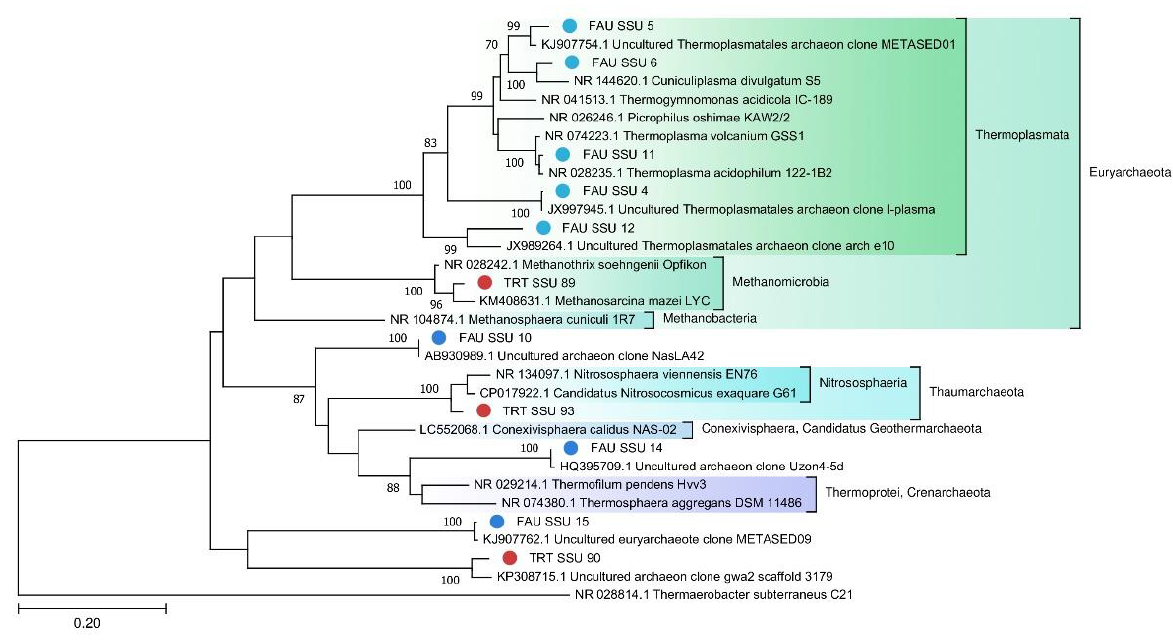
Figure 7. The phylogenetic tree of SSU rRNA belonging to the Archaea domain (The general time reversible model with gamma distribution (GTR + G)).